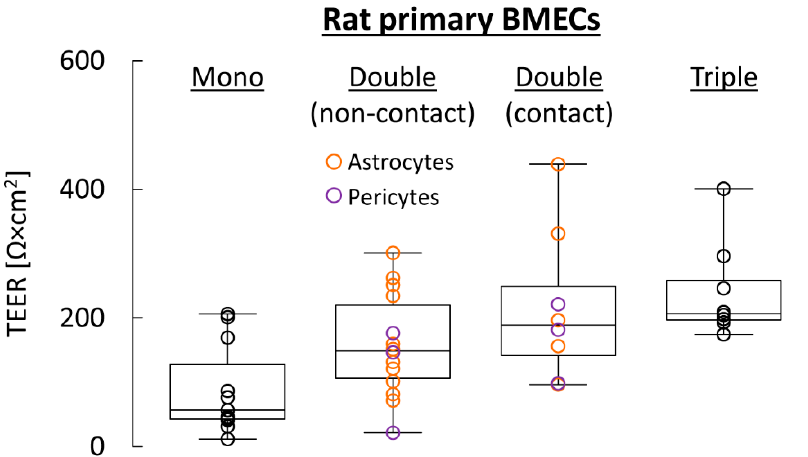
Figure 6. Effect of culture conditions on reported TEER values for static BBB models based on rat primary cells. Shown are individual values taken from the literature (open circles, for references see Table 1) and boxplots constructed from the median value, upper and lower quartiles (box) and minimum and maximum values (whiskers). As described in more detail in the main text, TEER values reported for non-contact co-cultures of rat brain microvascular endothelial cell (BMECs) with astrocytes or pericytes are usually about two-fold higher than the corresponding values for monolayer cultures of BMECs grown in the absence of other BBB cells. Even higher TEERs may be achieved by contact co-culture with either astrocytes or pericytes or by co-culture of all three cell types. Note that data from publications using hydrocortisone to increase TEERs have been excluded to facilitate comparison between the different culture conditions.